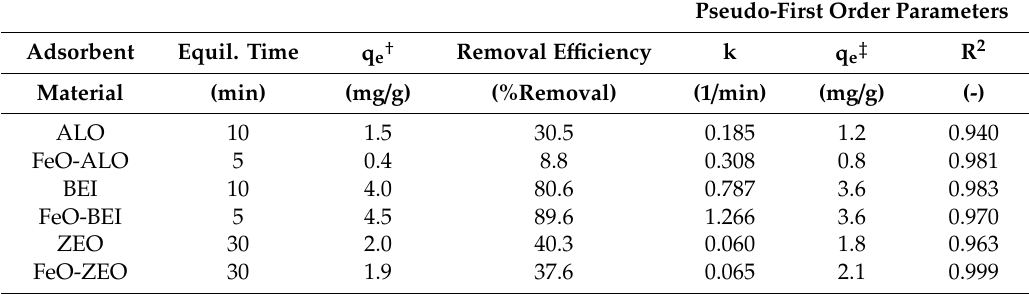
Table 3. Summary of the kinetics experiments. Reported are the equilibration time, the removal e ffi ciencies, the measured (q e † ) and calculated (q e ‡ ) adsorption capacities and the kinetic parameters for the adsorption of Ba 2 + by ALO, BEI and ZEO with(out)